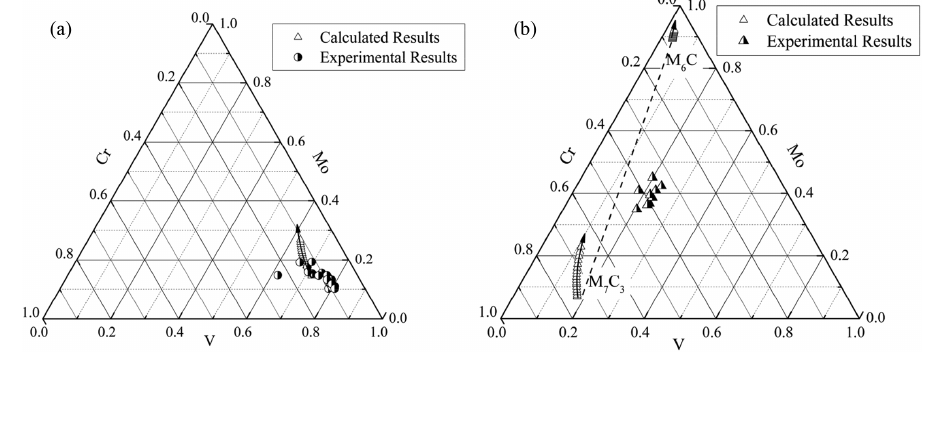
Figure 7: The compositional comparison between calculated results and experimental results.